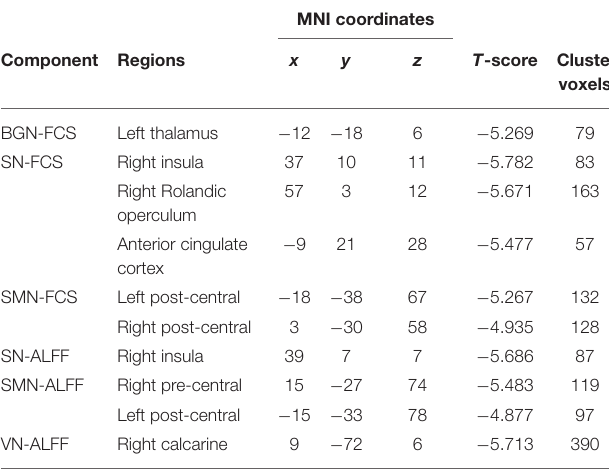
TABLE 2 | Largest spatial correlation score (SCS) between nine template of resting-sate networks and FCS-sDFN, as well as ALFF-sDFN. Template of resting-state